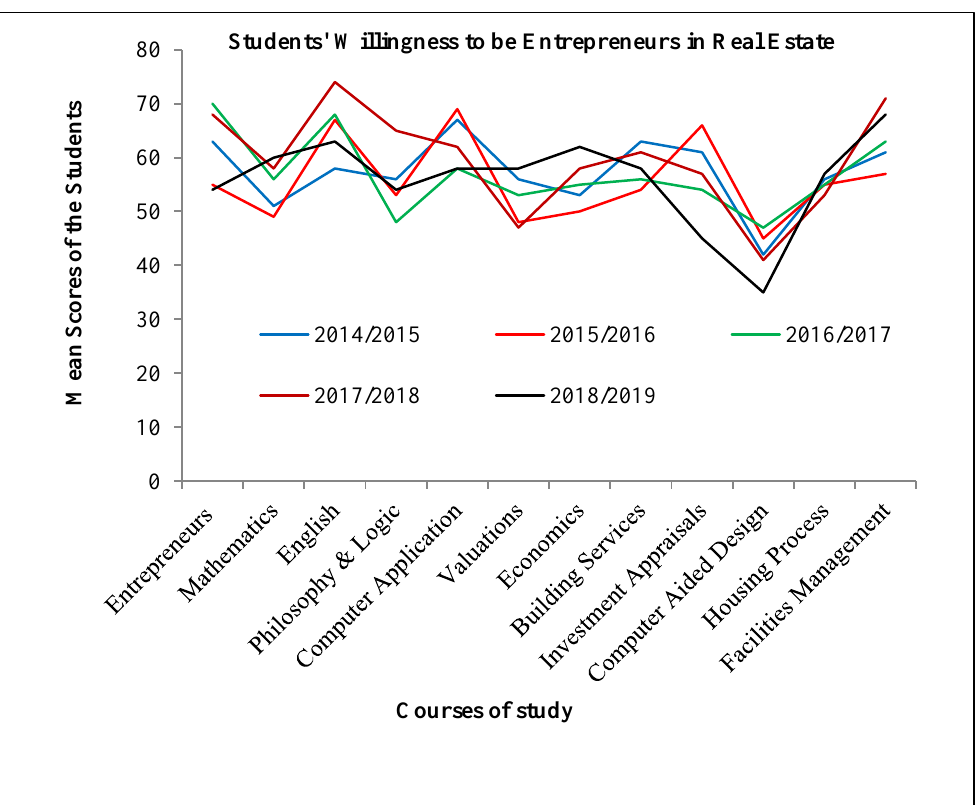
Fig. 4. The mean scores of the students’ willingness to adhere to real